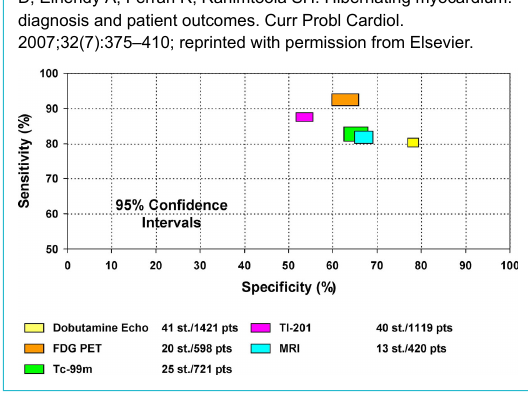
Figure 2: Comparison of different imaging modalities with regard to their ability to identify myocardial viability. Of note, FDG-PET yields highest sensitivity. From: Schinkel AF, Bax JJ, Poldermans D, Elhendy A, Ferrari R, Rahimtoola SH. Hibernating myocardium: diagnosis and patient outcomes. Curr Probl Cardiol. 2007;32(7):375–410; reprinted with permission from